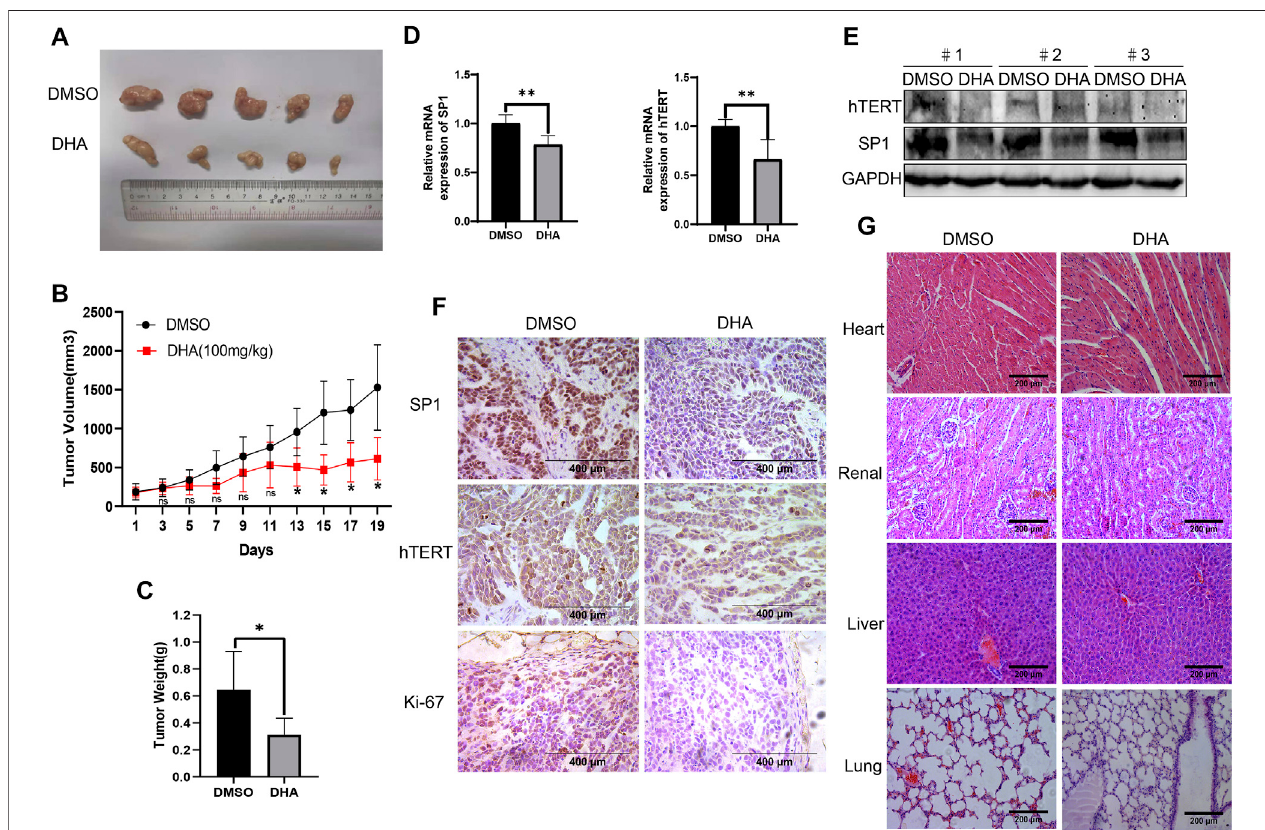
FIGURE 6 | DHA suppresses tumor growth of ESCC in vivo . (A) After mice were sacri fi ced on day 19th, the tumors were stripped and photographed. (B,C) The proliferation curve (B) and tumor weight (C) of tumors in xenograft mouse model treated with DHA or vehicle. (D,E) The expression of SP1 and hTERT in tumor tissues detectedbyPCRandWesternblot. (F) ImmunohistochemicalstainingforSP1,hTERT,andKi-67oftumortissuesfromxenograftmousemodel. (G) HEstainingofheart, liver, lung, and kidney in xenograft mouse model. (* indicate p < 0.05 and ** indicate p < 0.01 compared with control).